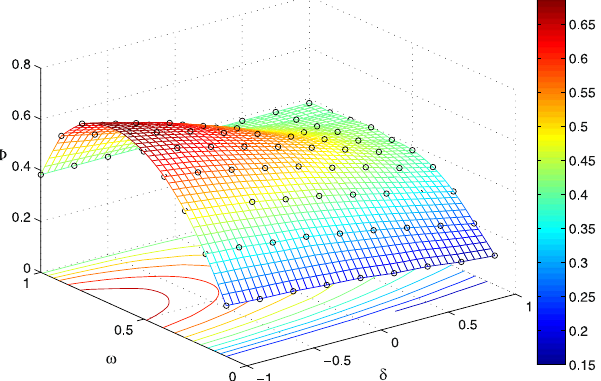
Figure 5. The Kriging-based response surface and contour plots for the disturbance effect. The original network is the same as the one we used in Fig. 2. The cost constraint parameter θ is 0.1. The circles represent the original experiment data, which are averaged over 100 realizations of disturbance strategy. The disturbance effect is obtained based on the structural robustness measure R